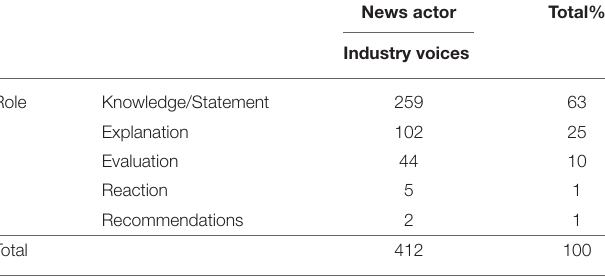
TABLE 4 | Industry voices by role.